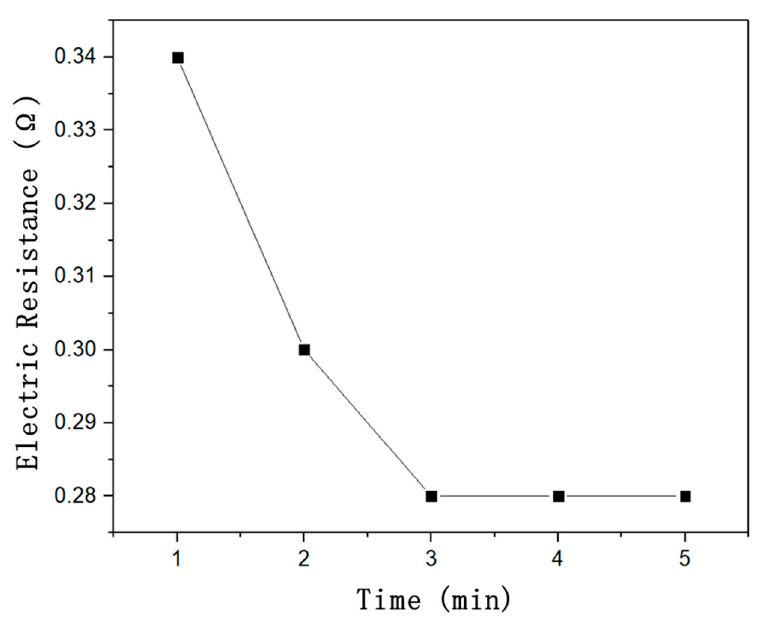
Figure 6. The relationship between the resistance of CFRE plate and time.